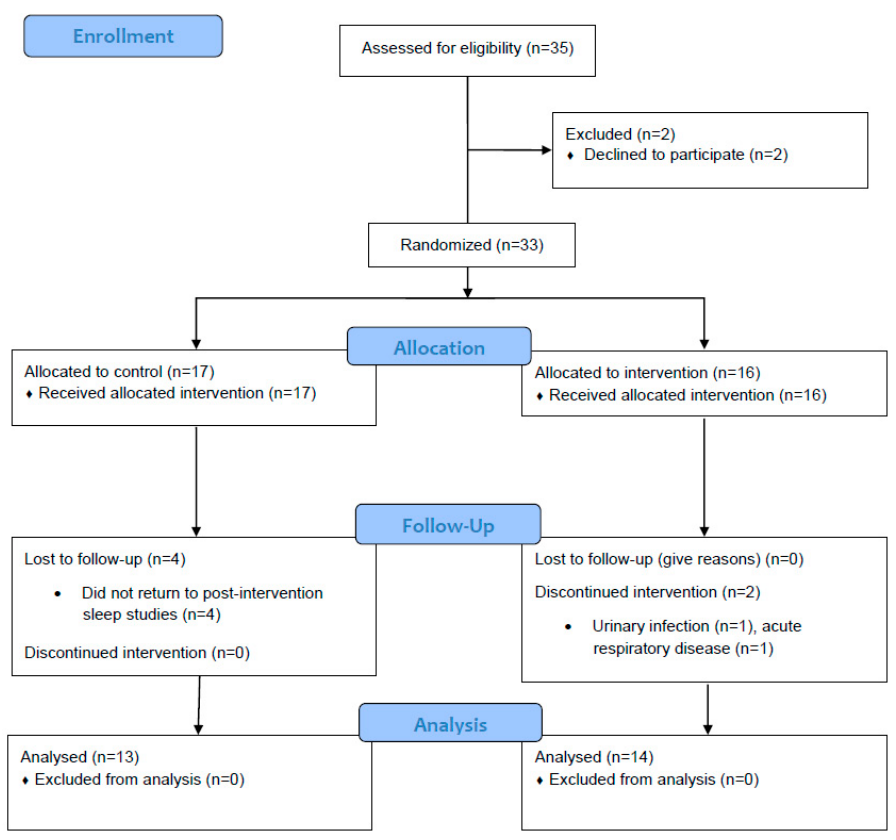
Figure 1. CONSORT flow chart of participants of study.